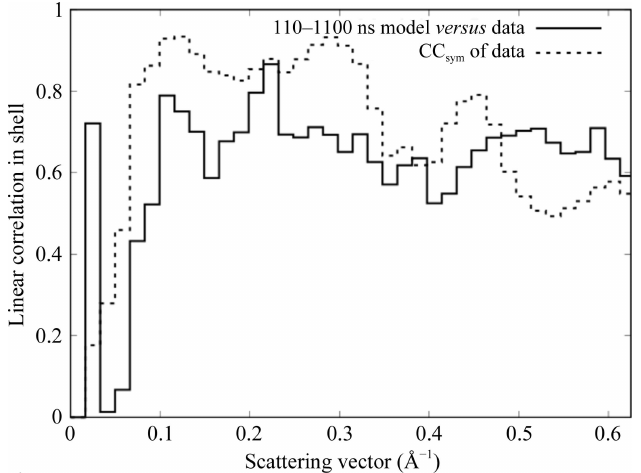
Figure 4 Resolution-dependent agreement between simulation and data (solid line) compared with the self-consistency of the data, as assessed using the expected P 4/ m symmetry (dotted